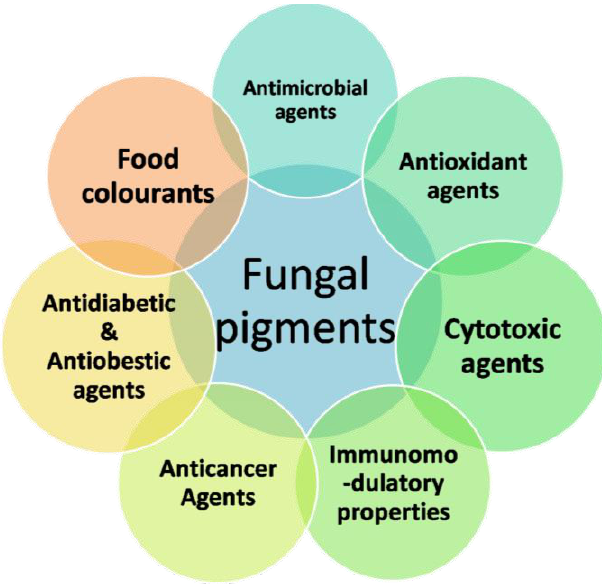
Figure 2. Applications of fungal pigments in the food industry.